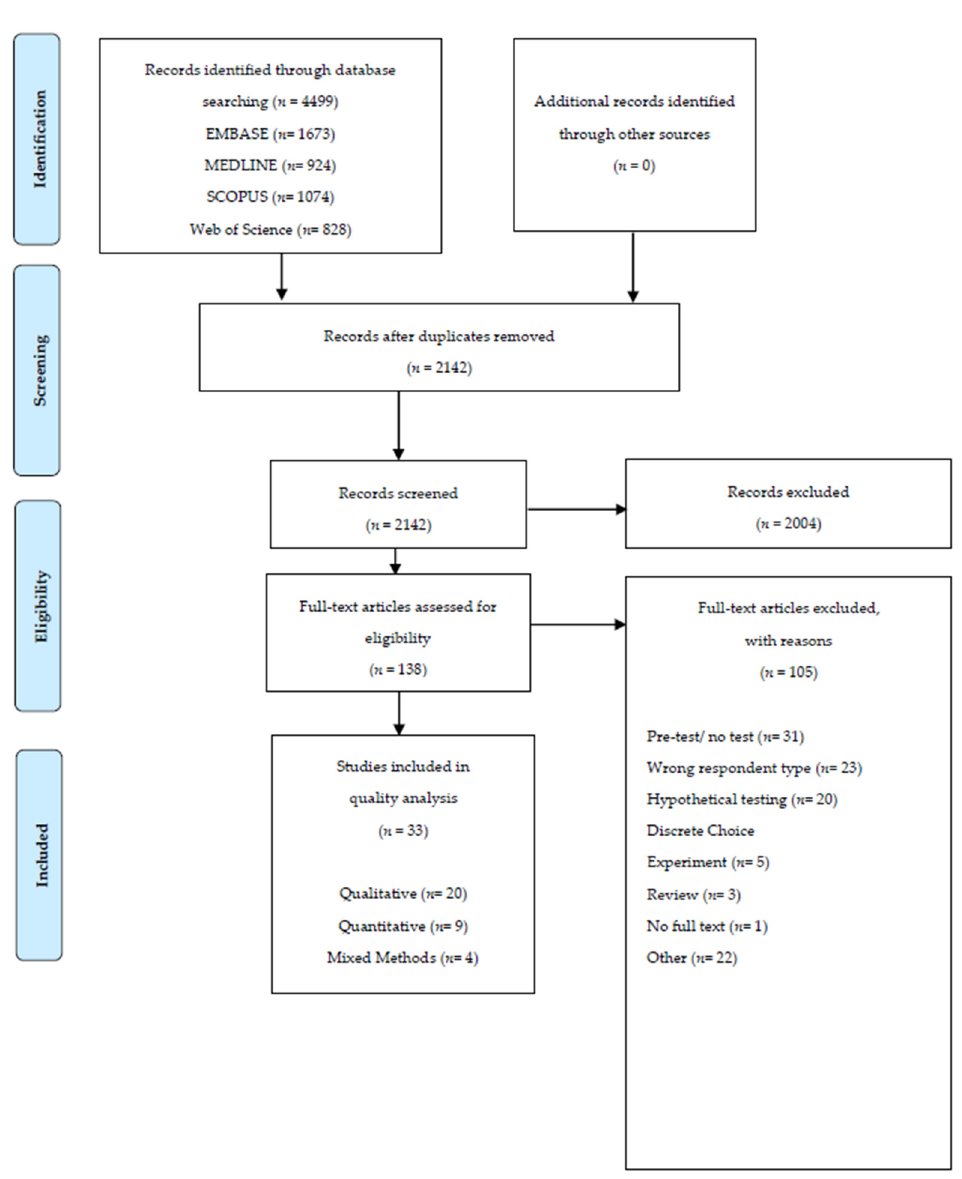
Figure 1. PRISMA flow diagram. Table 1. Study characteristics ( n = 33).